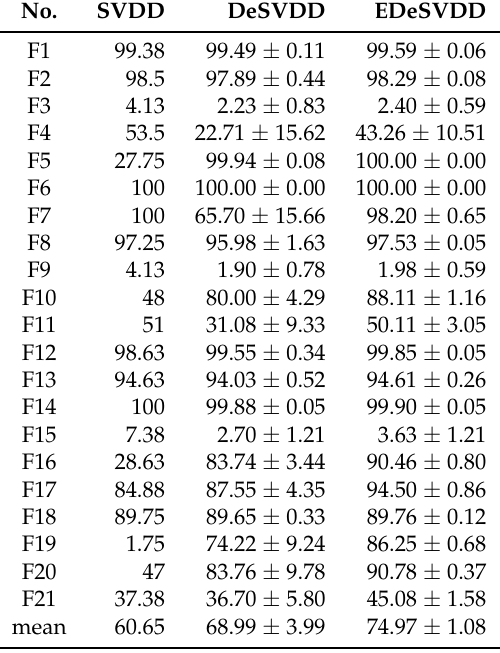
Table 2. Fault detection rates (FDRs)(%) of the TE process faults by the SVDD, DeSVDD and EDeSVDD methods.